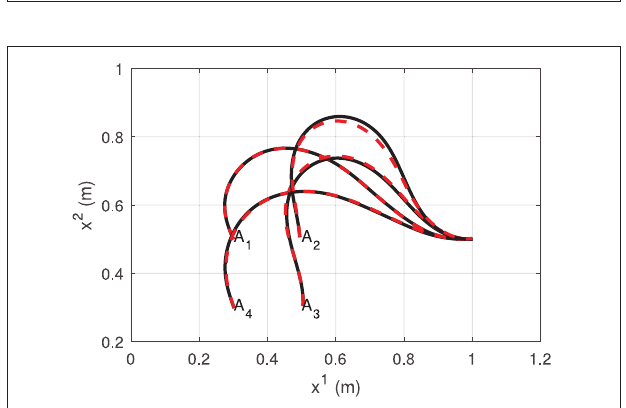
FIGURE 4 | Various configurations of the visually measured cable profile (black solid line) and its approximation with Fourier series (red dashed line).